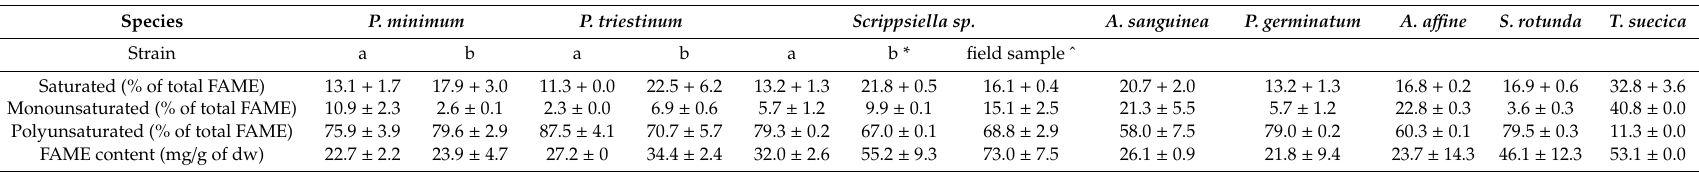
Table 5. Composition of fatty acids (% of total FAME) and FAME yield (mg / g of dw) in selected algal strains. Data expressed as mean ± SD (n = 3). Species P.